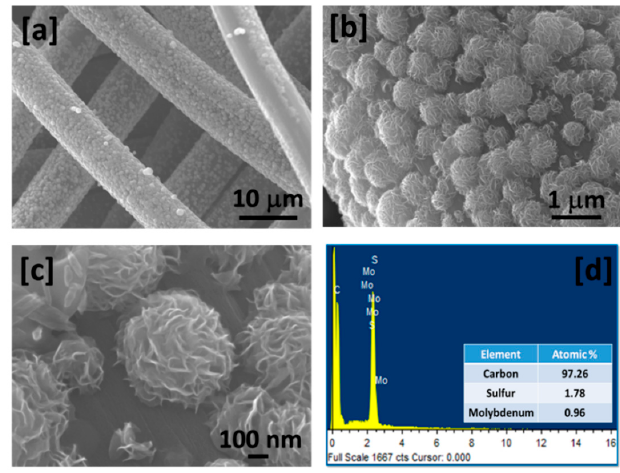
Figure 3. ( a – c ) Scanning electron microscopy (SEM) images at various magnifications; and ( d ) Energy Dispersive x-ray Spectrum (EDS) of MoS 2 grown over CNFs.